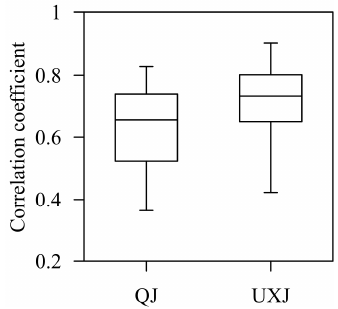
Figure 3. The boxplot of the correlation coe ffi cient between Soil Moisture Active Passive (SMAP) soil moisture product and the European Space Agency Climate Change Initiative (ESA CCI) Soil Moisture dataset (version 04.4) across Qujiang (QJ) and Upper Xijiang (UXJ) catchments during April 2015–June 2018, among which, p -values are far below